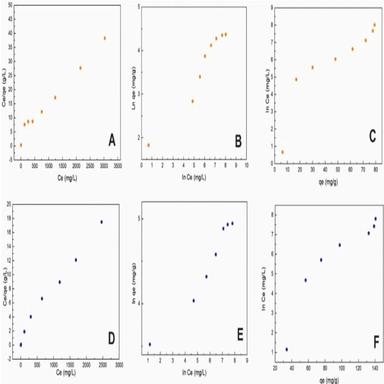
HC-g-Am-BIS-BT (A-C) and Am-BIS-BT (D–F). Plots of (A and D) Langmuir, (B and E) Freundlich isotherms and Tempkin isotherms (C and F).